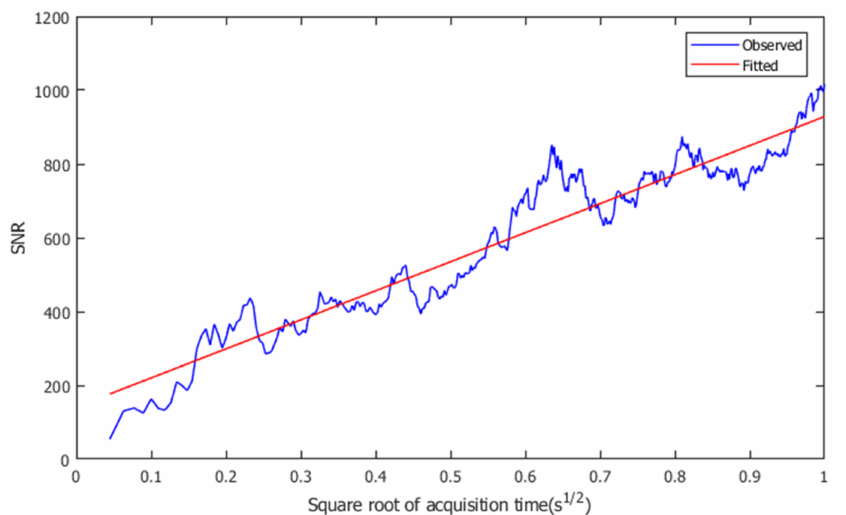
Figure 6. Signal noise ratio (SNR) improvement with the increase of averaging time. The blue line represents observed SNR, while the red line is the linear fit result. It is verified that the relationship between the square root of acquisition time and SNR is linear, and the SNR would keep increasing for longer acquisition